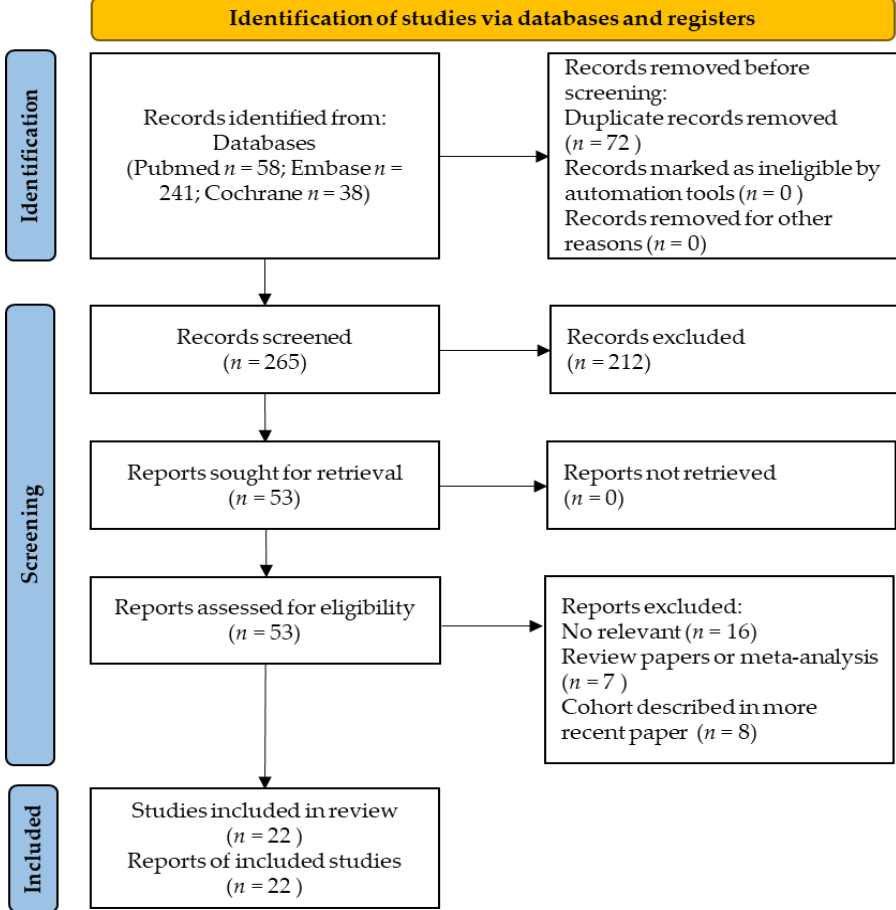
Figure 1. Preferred Reporting Items for Systematic Reviews and Meta-Analyses (PRISMA) flow diagram for study selection.